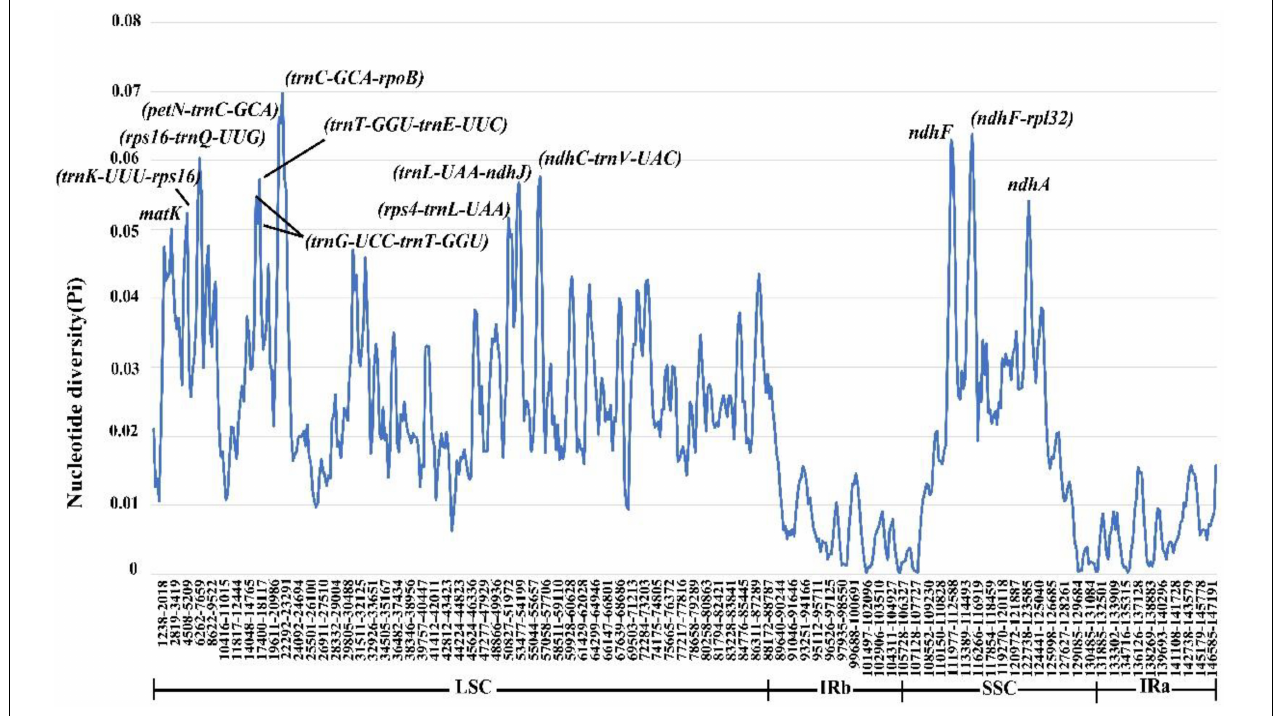
FIGURE 9 | Nucleotide diversity of the chloroplast genomes of C. subtilis and its related species.